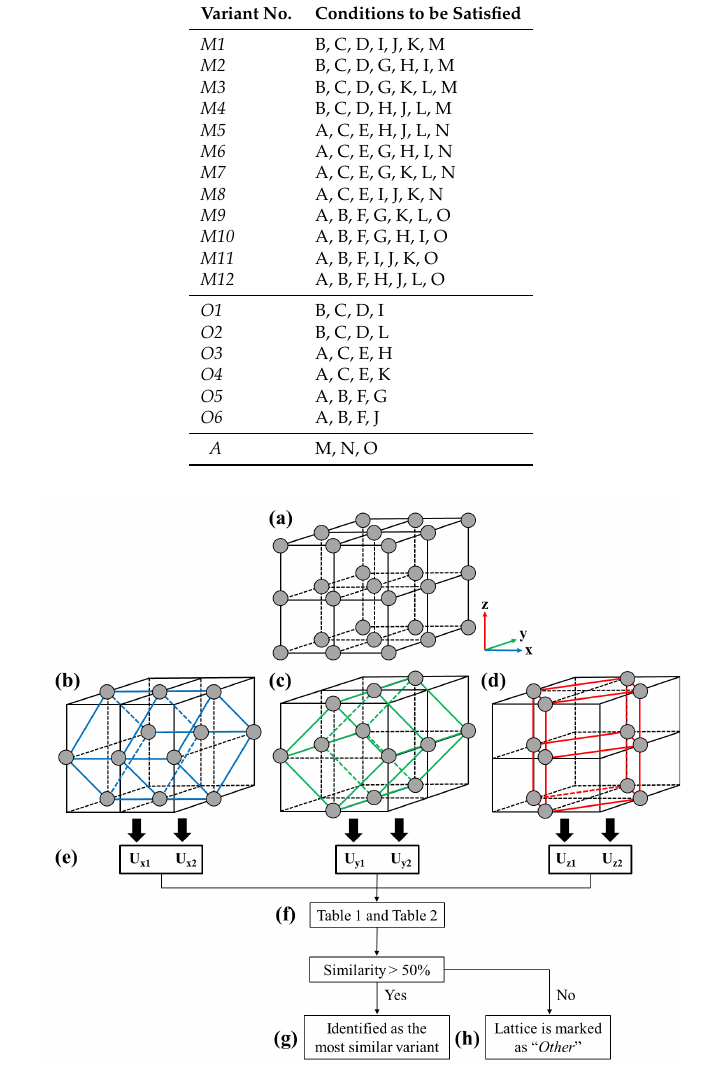
Figure 1. The procedures of the martensite variant identification method. ( a ) the eight cubic unit cells, ( b – d ) the six tetragonal unit cells, ( e ) the transformation matrices of the six tetragonal unit cells, ( f ) conditions checked in Tables 1 and 2, and ( g , h ) the variant can be